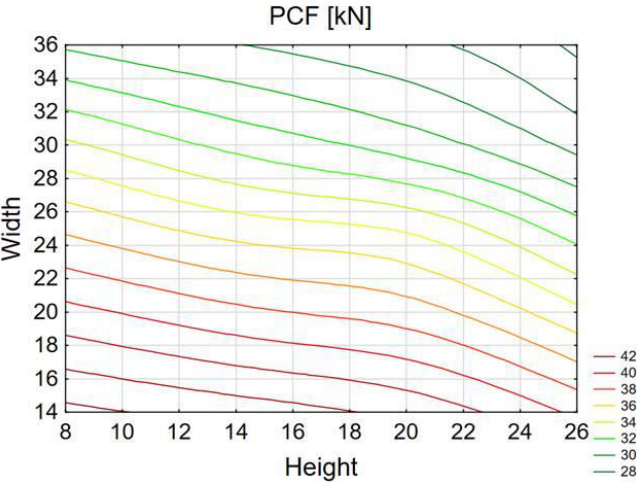
Figure 12. Predicted PCF value for the different widths and heights of the initiator.